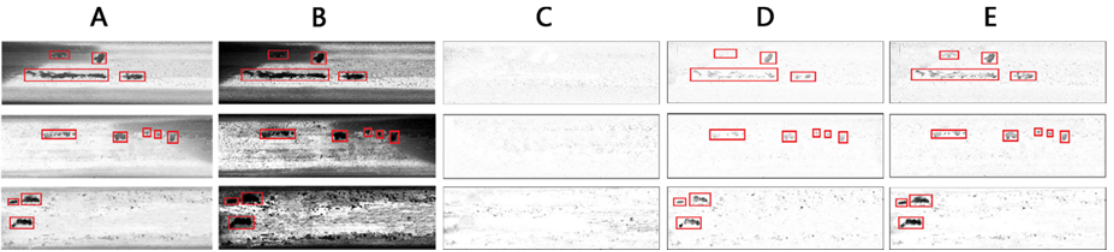
Figure 10. Examples of four enhancement methods for non ‐ uniform illumination rail images. ( A ) Three examples of extracted rail images. ( B ) Three examples of enhancement image by HE method. ( C ) Three examples of enhancement image by LN method. ( D ) Three examples of enhancement image by MLC algorithm. ( E ) Three examples of enhancement image by LWLC algorithm. In Figure 10, the discrete defects on images have been marked by red rectangle to compare enhancement performance of LWLC algorithm with related methods.